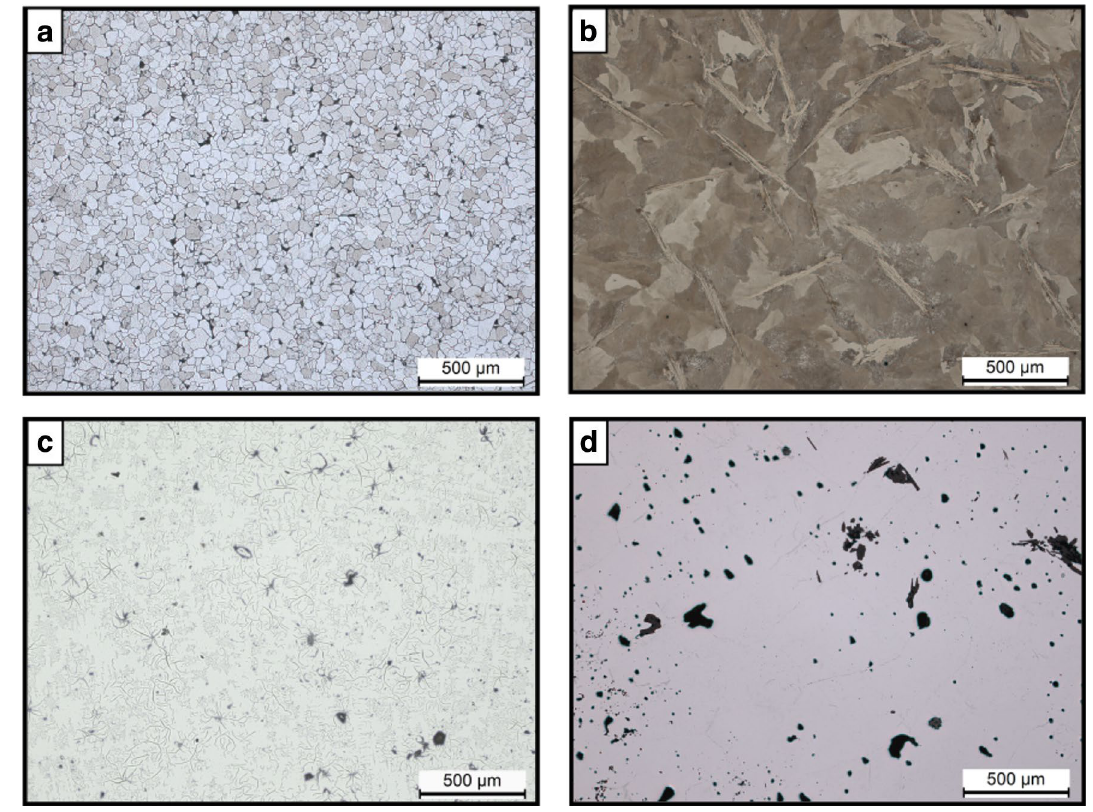
Fig. 2 Microstructure of the collector bar ( a , b ) and cast iron ( c , d ) in its initial states ( a , c ) and after 5 years of service in an electrolysis cell ( b , d ) Table 1 Chemical composition of collector bar (CB) and cast iron (CI) in wt% [15–17], the positions are corresponding to Fig. 3. The chemical composition of the collector bar after usage in the cell